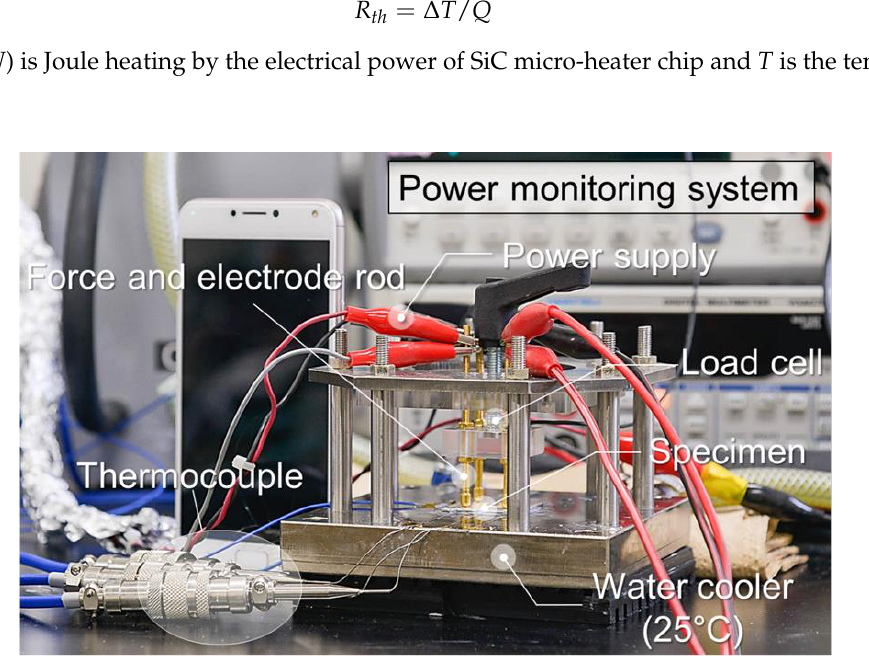
Figure 4. Power cycling test system with SiC micro-heater chip.